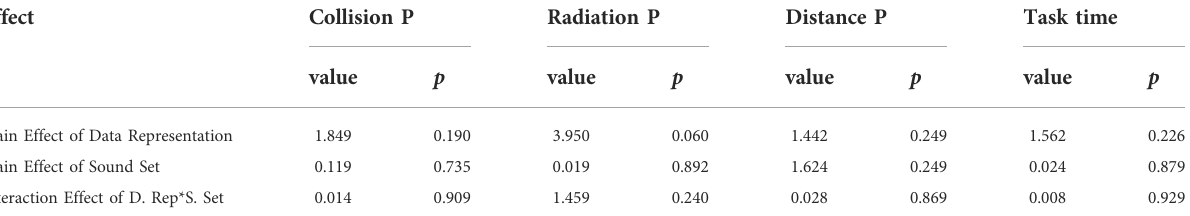
TABLE 11 Statistical analysis of performance measure